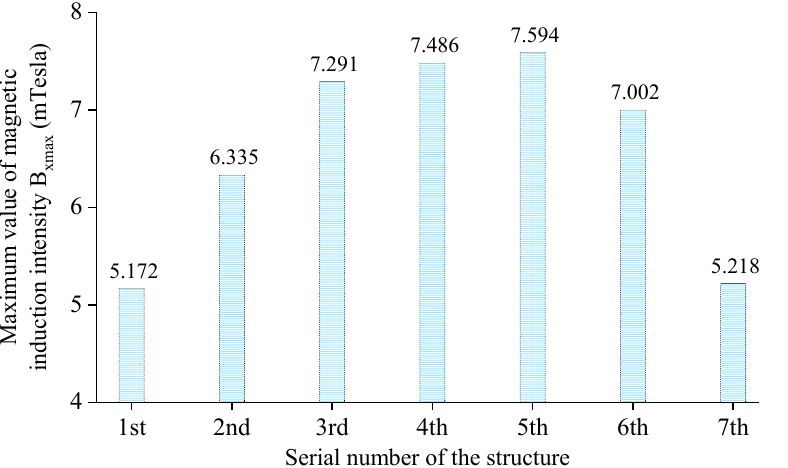
Figure 8. The correspondence curve between the winding structures of the magnetic field coil and the maximum value of magnetic induction. Table 5. The numerical correspondence between the structure of each winding of the magnetic field coil and the maximum value of magnetic.